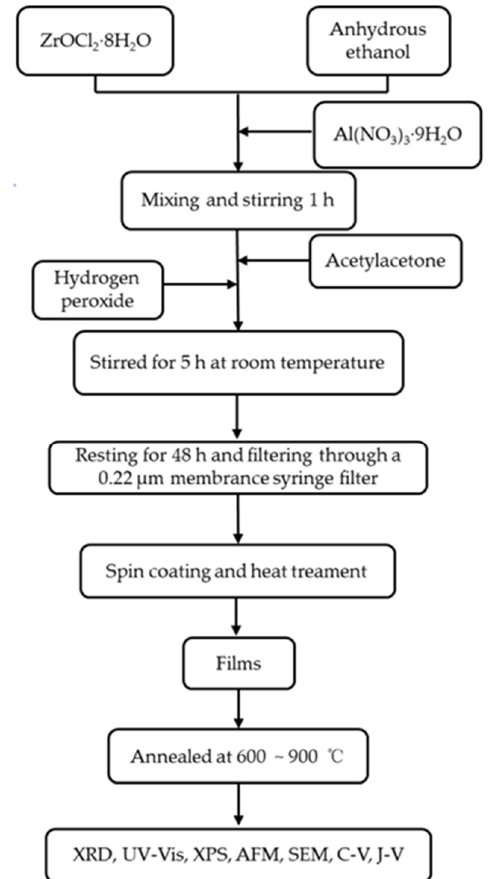
Figure 1. Schematic flow chart of AZO thin film preparation by sol–gel method.